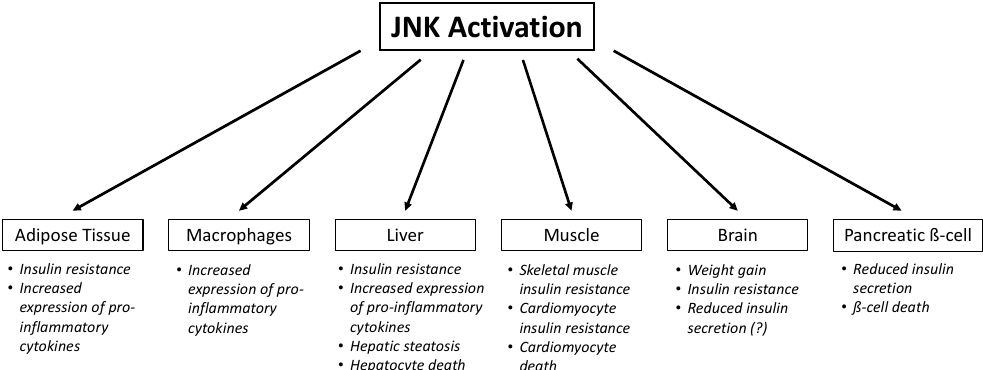
Figure 2. Chronic JNK activation in di ff erent tissues leads to di ff erent e ff ects. Since JNK has widespread action in di ff erent tissues, it is an important contributor of obesity-induced insulin resistance and T2D. In adipocytes, JNK activation causes adipocyte insulin resistance and the increased expression of pro-inflammatory cytokines such as TNF α , IL-6 and IL-1ß. In macrophages, JNK activation also causes increased expression of pro-inflammatory cytokines that promotes M1-polarization, the pro-inflammatory phenotype, and subsequent recruitment of more M1 macrophages. In the liver, JNK activation causes hepatic insulin resistance, steatosis, and hepatocyte death. In myocytes, JNK activation causes skeletal muscle insulin resistance and cardiomyocyte insulin resistance and cardiomyocyte death. In pancreatic ß-cells, JNK activation reduces insulin secretion and ß-cell death. In the brain, particularly the hypothalamus, JNK activation causes central insulin resistance, which impacts energy homeostasis (mainly inducing food intake and weight gain), brain regulation of glucose production, and might also reduce insulin secretion by β